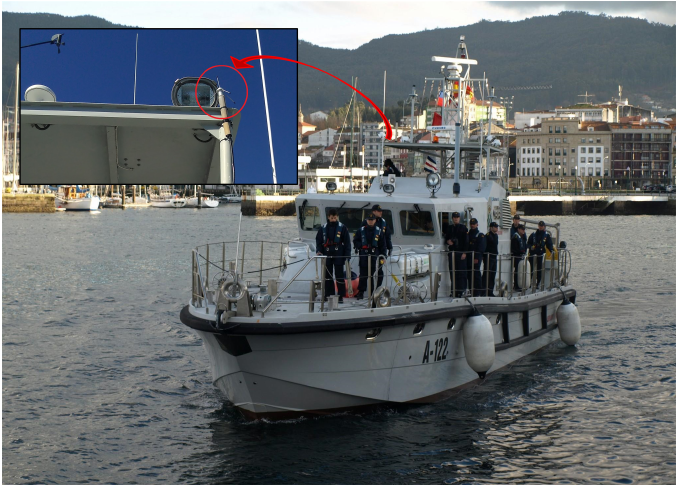
Figure 24. Instruction boat with the measurement node and the omnidirectional antenna for the radio link test.